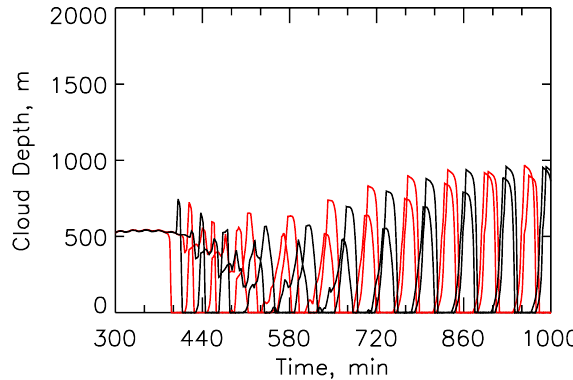
Fig. 3. One-dimensional solution to the equations for I = 21, τ c = 10 . 75min (0 . 5 T ), and η = − 0 . 48. Red lines: i = 5 and i = 7; black lines: i = 6 and i = 8. As in Fig. 2, all clouds are initially synchro- nized with H ’ 500m. System undergoes a period of no phase or frequency coherence from about 400–600min. Thereafter the sys- tem behaves much like Fig. 2 with clouds growing at the expense of their neighbours. Note the slower frequency of oscillation asso- ciated with the longer τ c